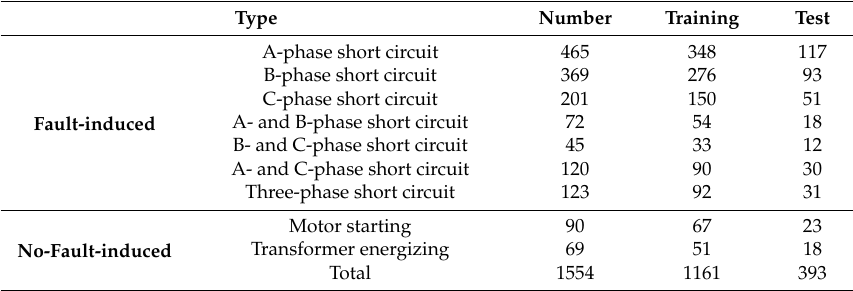
Table 1. Training and test